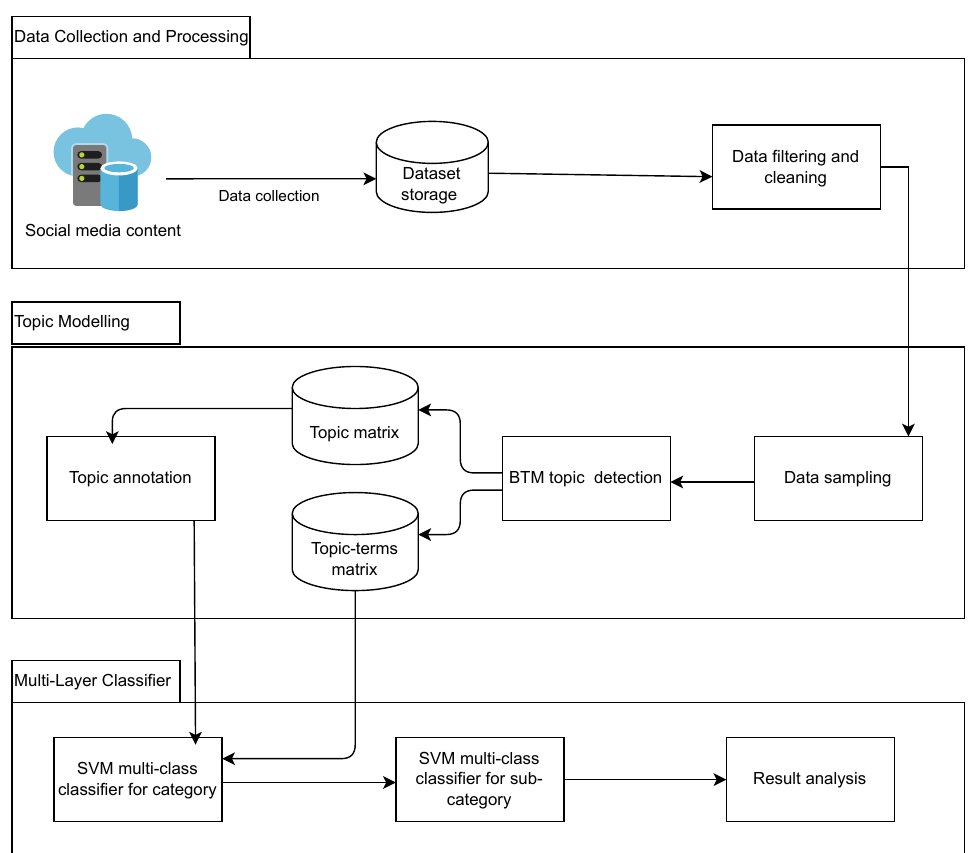
Figure 2. The structure of the